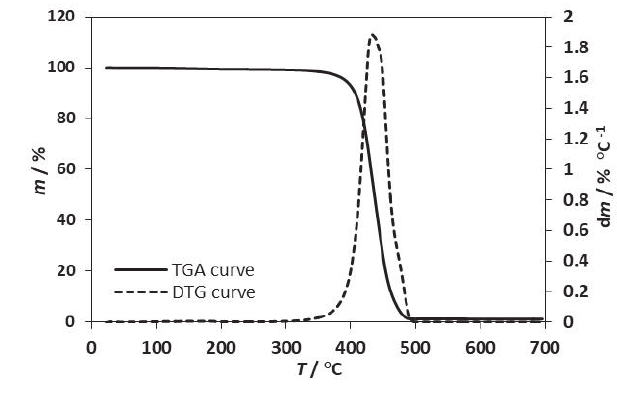
Fig. 6 – TGA and DTG curves of PA